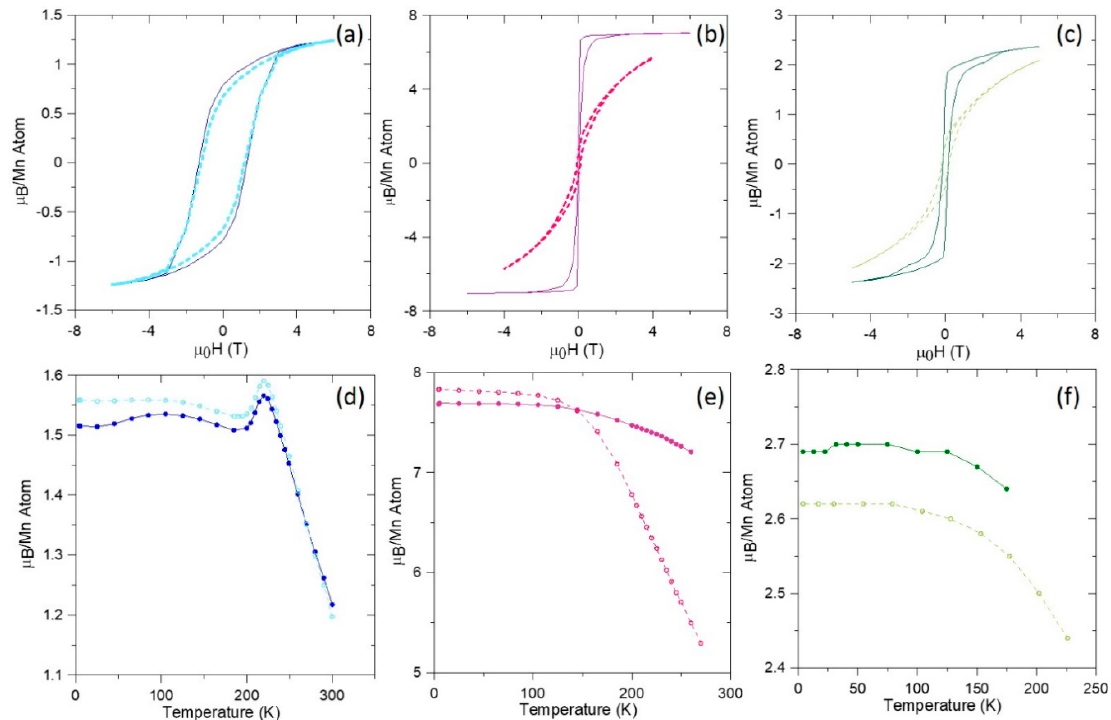
Figure 5. Magnetization versus field at 300 K and moment per Mn ion versus temperature at 5 T, respectively, of samples with the following compositions: ( a , d ) 2 at.% MnBi; ( b , e ) 10 at.% MnBi; ( c , f ) 35 at.% MnBi. Traces were taken with the field applied parallel (full curves, darker colors) and perpendicular (dashed curves, lighter colors) to the direction along which the annealing field was applied.